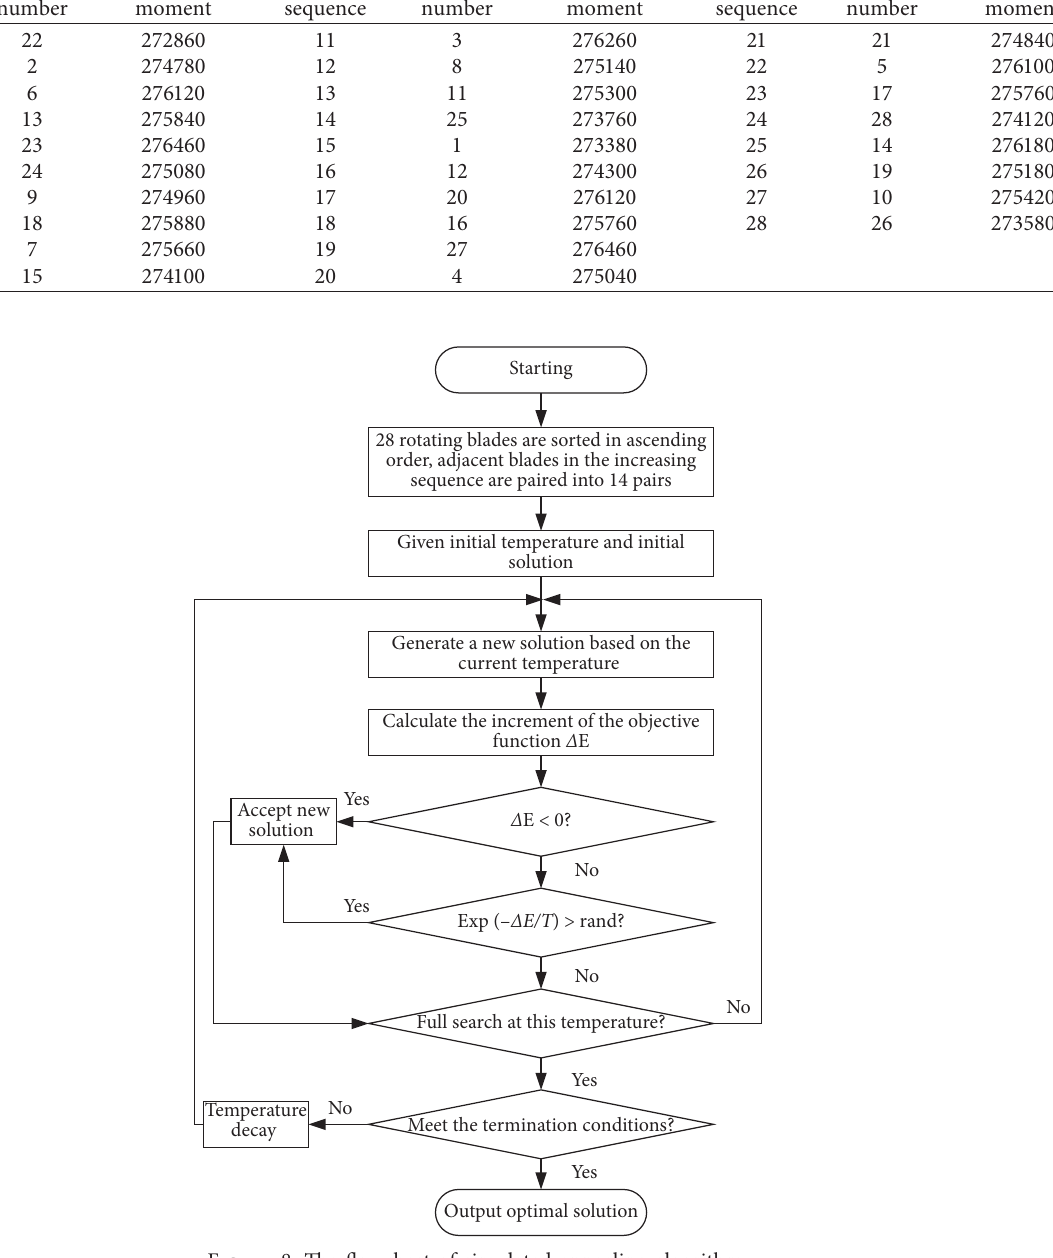
Figure 8: The flowchart of simulated annealing